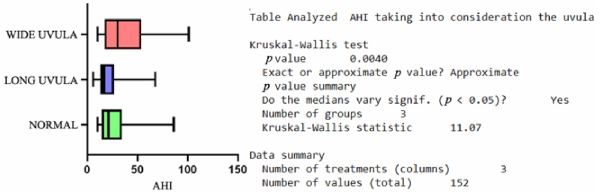
Figure 1. Distribution of AHI inside the study group taking into consideration the uvula morphology.